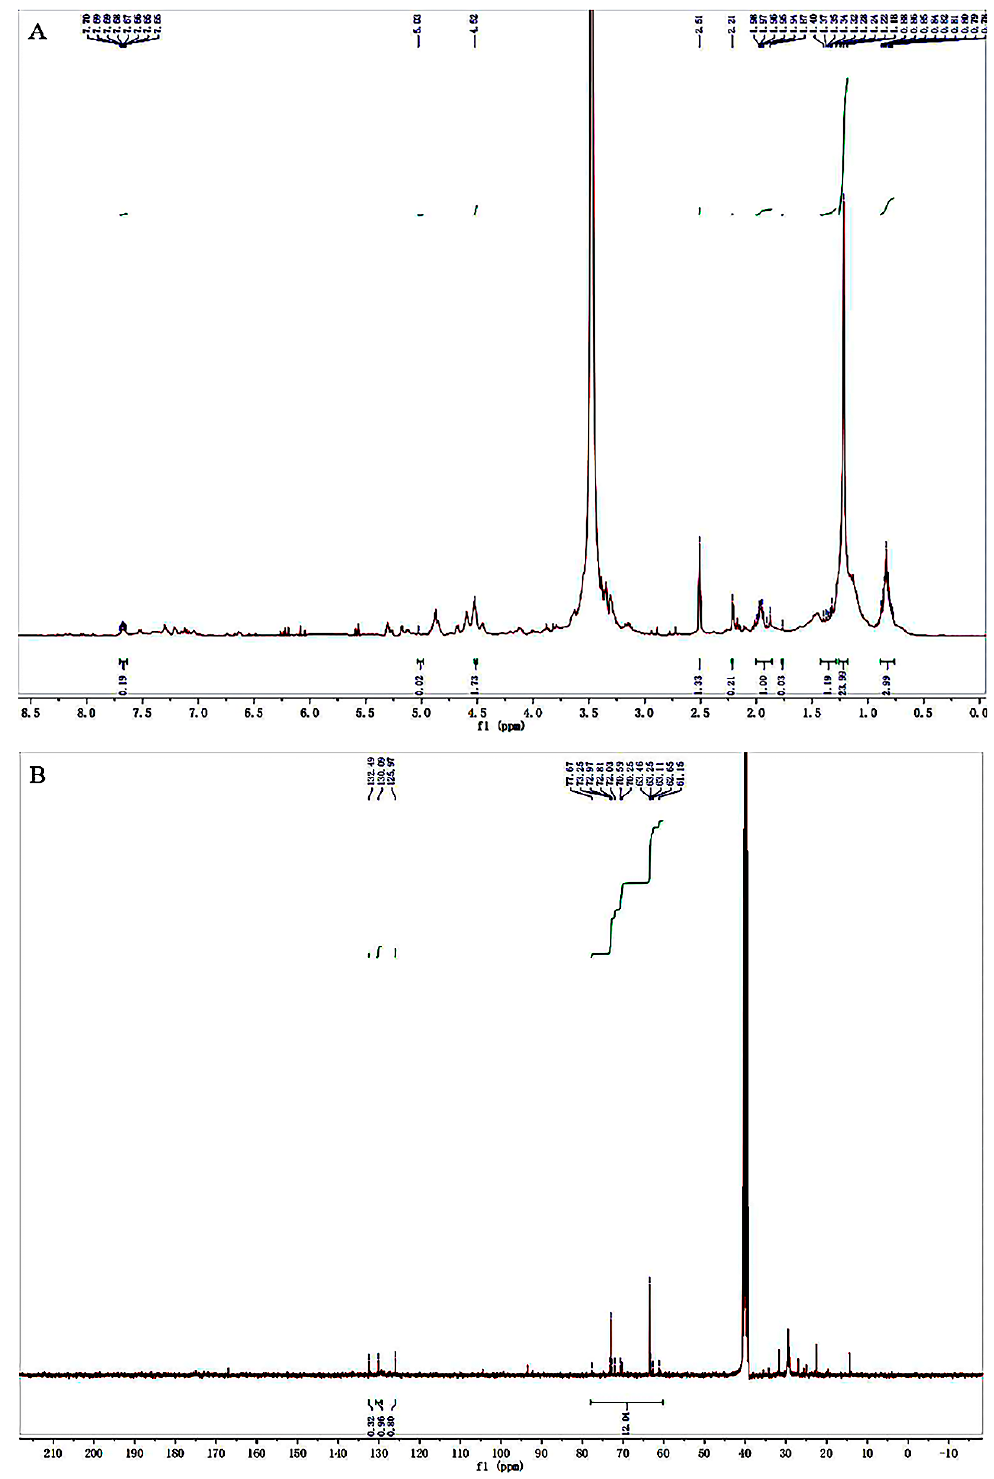
Figure 3. 1 H NMR ( A ) and 13 C NMR ( B ) spectra of purified pigment from G. rubripertincta GH-1.